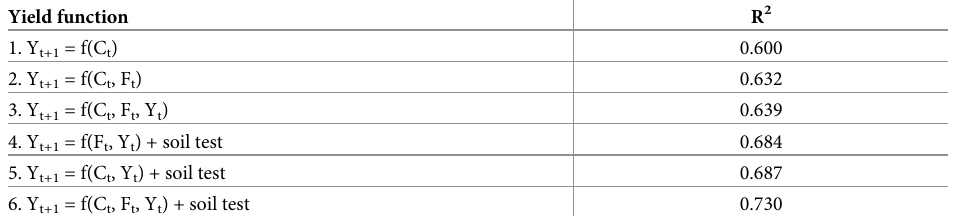
Table 6. Accuracy of Random Forest regression models ( Y t , Y t+1 for yield, t for current year, F t for fertilization regime, and C t for tissue composition) using the Quebec 2014–2018 fertilization trials with cultivar